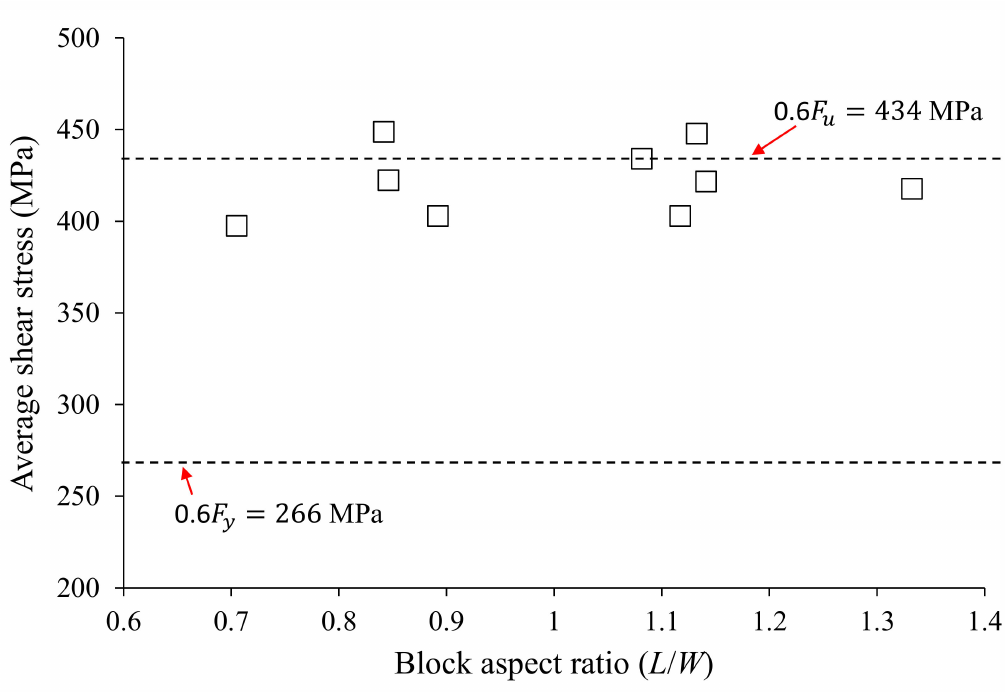
Figure 11. Average shear stresses of the welded